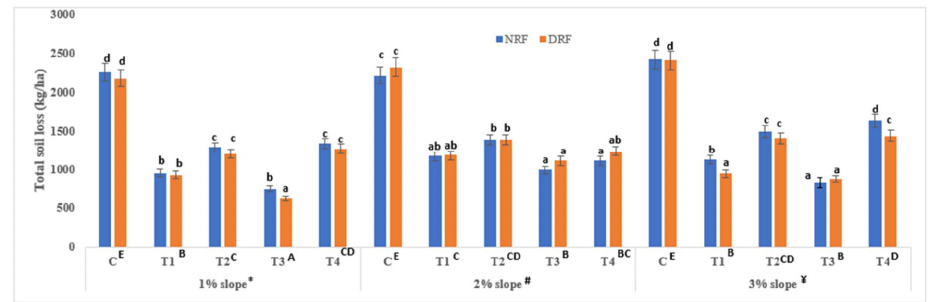
Figure 2. Effects of grass strip treatment on total soil loss through runoff sediments (kg/ha) across variable slopes (1–3%) in two different rainfall situations. ABCDE differ significantly at a 1% level of significance between the treatments, irrespective of the slopes. abcd differ significantly at a 5% level of significance between the treatments within a particular slope level at different rainfall situations. * #¥ differ significantly at a 1% level of significance between the slopes. T1, top and bottom Stylosanthes strip; T2, only bottom strip of Stylosanthes ; T3, top and bottom Brachiaria strip; T4, only bottom strip of Brachiaria .